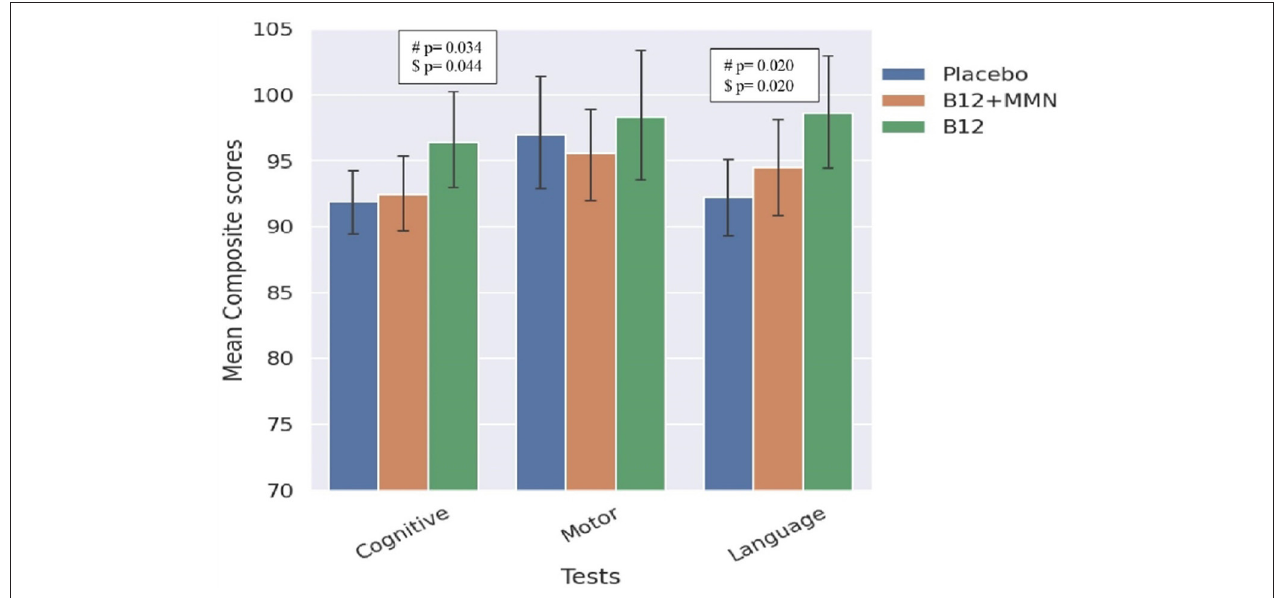
FIGURE 2 | Bar graph comparing scores in BSID-III domains between treatment and placebo groups. Comparison between placebo and treatment groups on BSID-III domains. # significance at p < 0.05, $ significance p < 0.05 value adjusted for maternal baseline B12 levels. Error bars represent 95% confidence